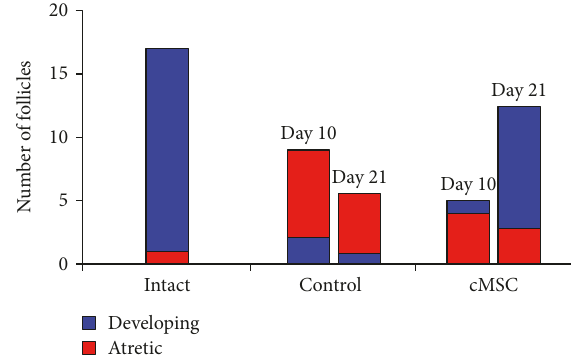
Figure 6: The number of developing and atretic follicles in the ovaries. In the control group, atretic follicles strongly dominated over developing forms on the 10th day, and after cell administration, their number was almost equal. On the 21st day, the ratio of developing and atretic follicles in the ovaries of animals with cMSC injection dramatically increased, while in the control, it still remained on the side of atretic